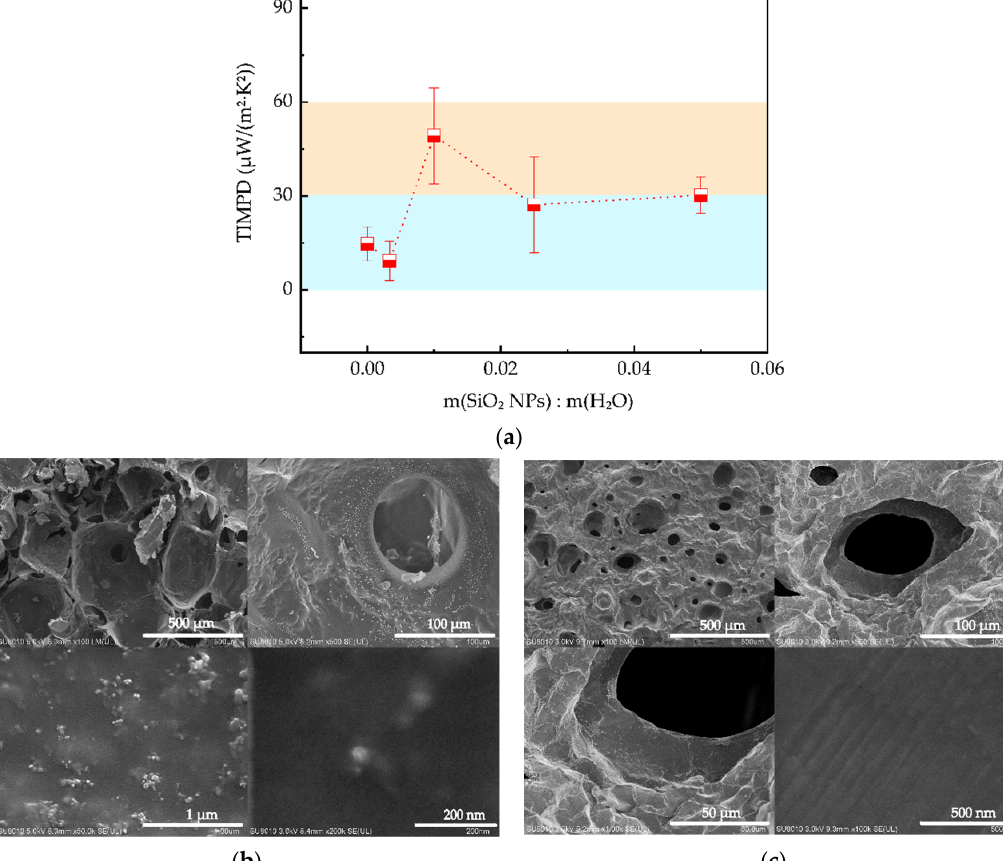
Figure 4. ( a ) The temperature-insensitive maximum power density (TIMPD) of the prepared TEG units with different quantity of SiO 2 NPs; ( b ) SEM images of the iTEG with SiO 2 NPs; ( c ) SEM images of the iTEG without SiO 2